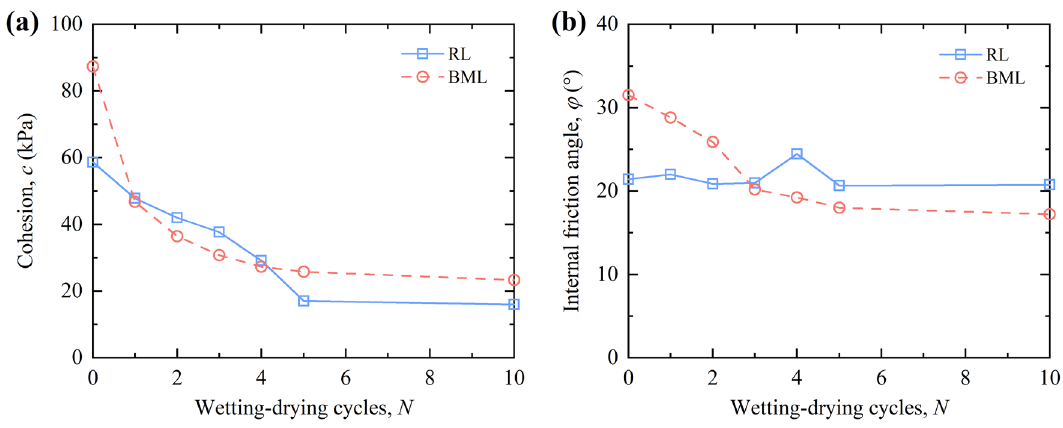
Figure 12. Strength parameters of loess under W–D